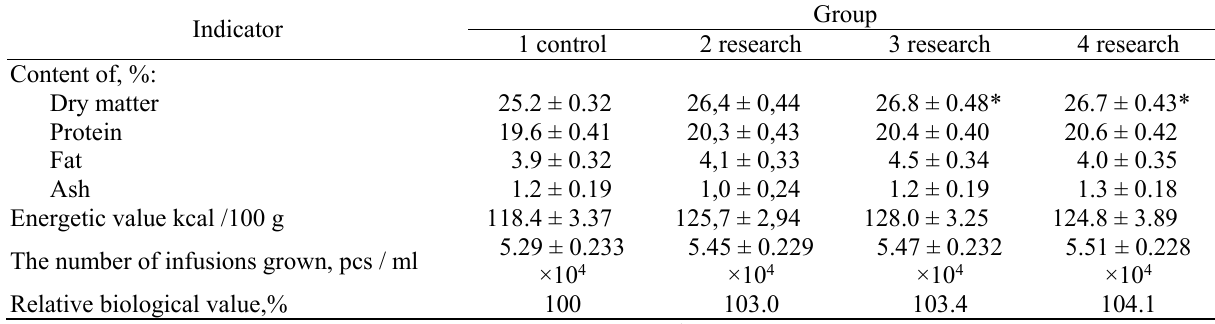
The chemical composition and biological value of the gosling breast muscles (Х ± S х , n = 3)